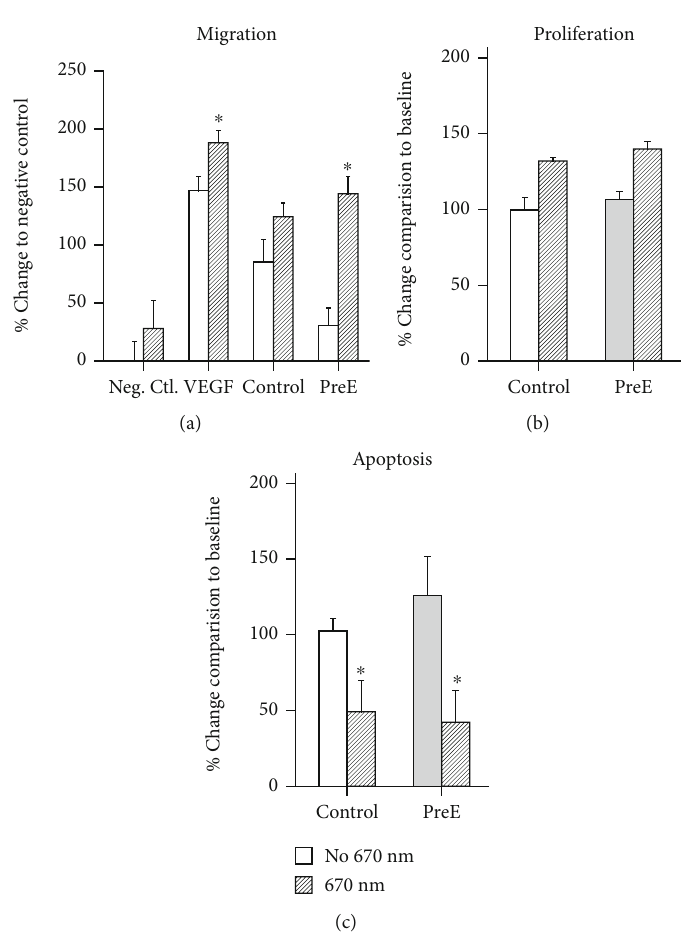
Figure 6: (a) 670 nm light improves migration of trophoblasts on pre-E pECM. (b) 670 nm light improves proliferation of trophoblasts on pre-E pECM. (c) 670nm light reduces the number of apoptotic trophoblasts on pre-E pECM. ( p ≤ 0 : 05 , n = 4 ).